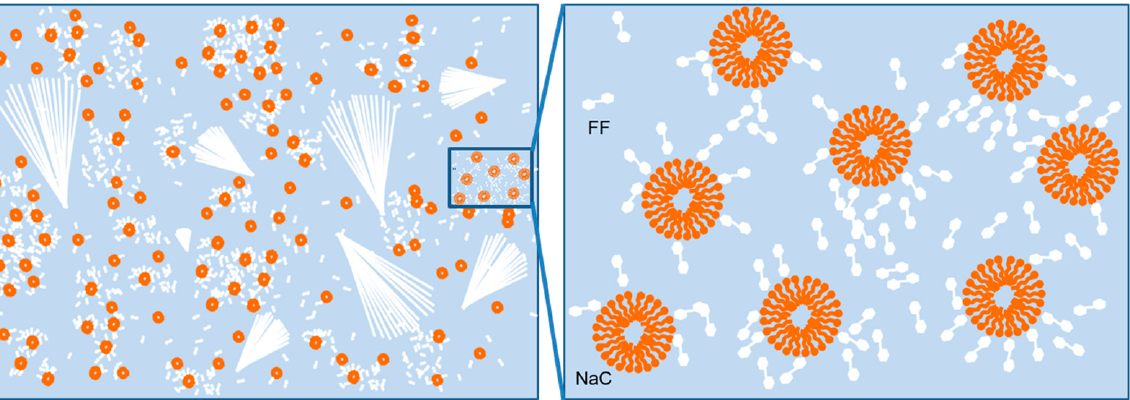
Figure 5. The dispersion, nucleation and growth of FF with an NaC concentration around the CMC.